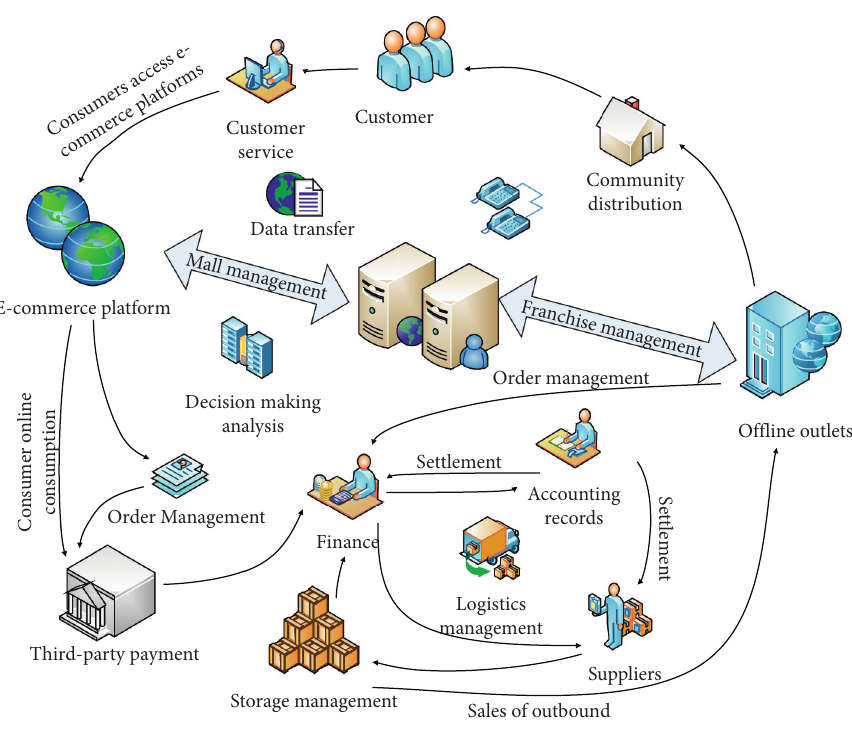
Figure 1: Transaction business process of e-commerce system based on big data.